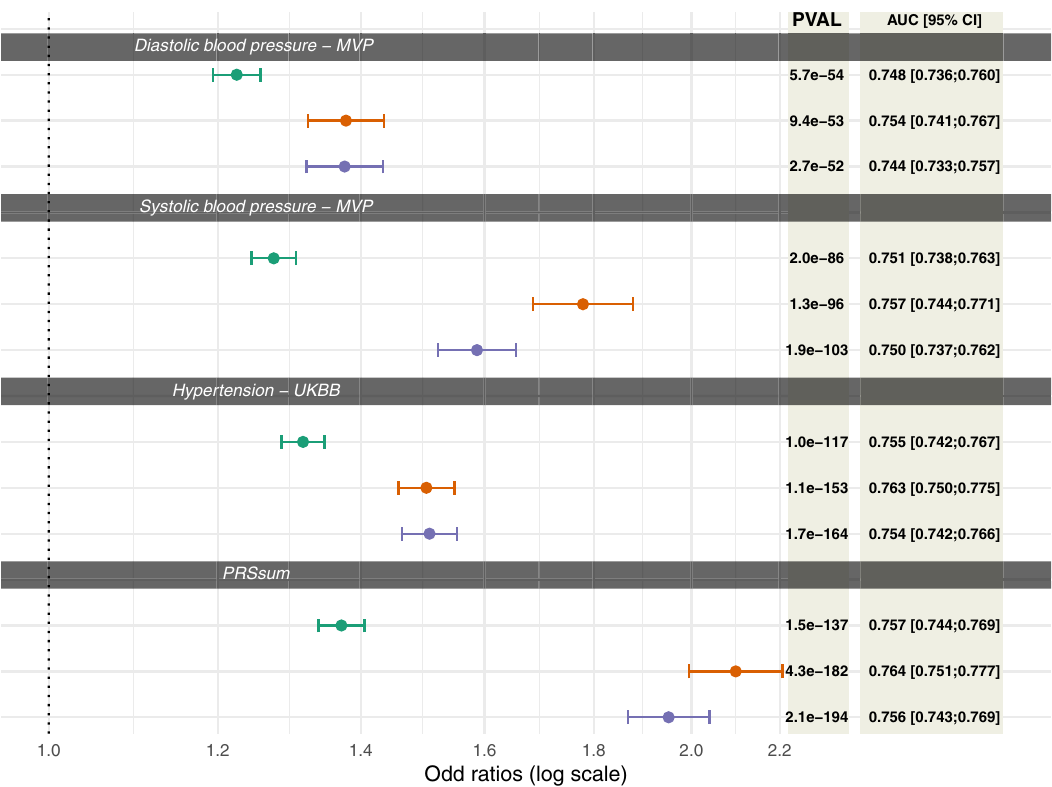
Fig. 2 Association of PRS with prevalent hypertension at baseline in the stage 2 data set. Associations of PRS in stage 2 dataset ( N = 37,667 individuals). PRS were trained for hypertension association using stage 1 dataset. “ Genome-wide signi fi cant PRS ” are PRS constructed using genome-wide signi fi cant SNPs in the discovery GWAS, with fi xed LD parameters or R 2 = 0.1 and distance = 1000 kb. “ Selected CV PRS ” are PRS that minimized the coef fi cient of variation (CV) across effect size (log odds ratio (OR)) estimates in 5 independent subsets of the stage 1 dataset. “ Selected PVAL-PRS ” are PRS that minimized the association p value with hypertension in the stage 1 dataset. Each point provides the estimated OR per 1 standard deviation (SD) increase of the PRS, and error bars represent 95% con fi dence intervals (CIs). For each PRS association the fi gure also provides the p value of the estimated association with hypertension based on the Wald test (chi-squared test with one degree of freedom based on two-sided alternative hypothesis), and Area Under the Receiver Operator Curve (AUC). PRS associations were estimated in models adjusted for sex, age, age 2 , study site, race/ethnic background, smoking status, BMI, and 11 ancestral principal components. PRS SDs were de fi ned according to the sampling SDs of the PRS estimated in the entire TOPMed